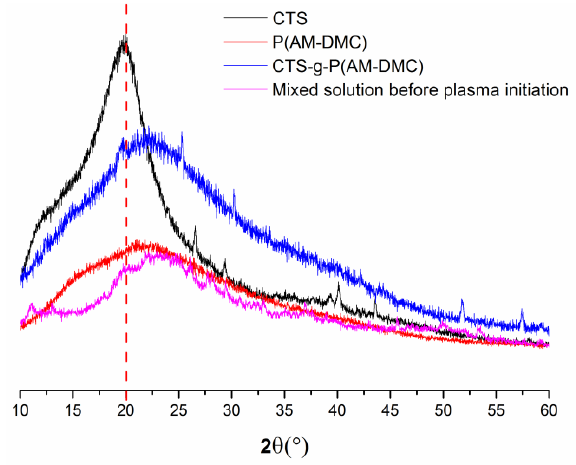
Figure 3. X-ray diffraction spectroscopy (XRD) patterns of CTS, P(AM-DMC), CTS- g -P(AM-DMC), and the mixture